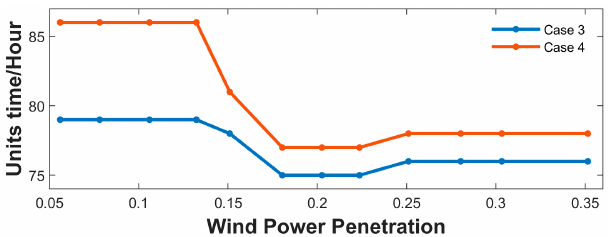
Figure 10. Unit times with different wind power penetration.